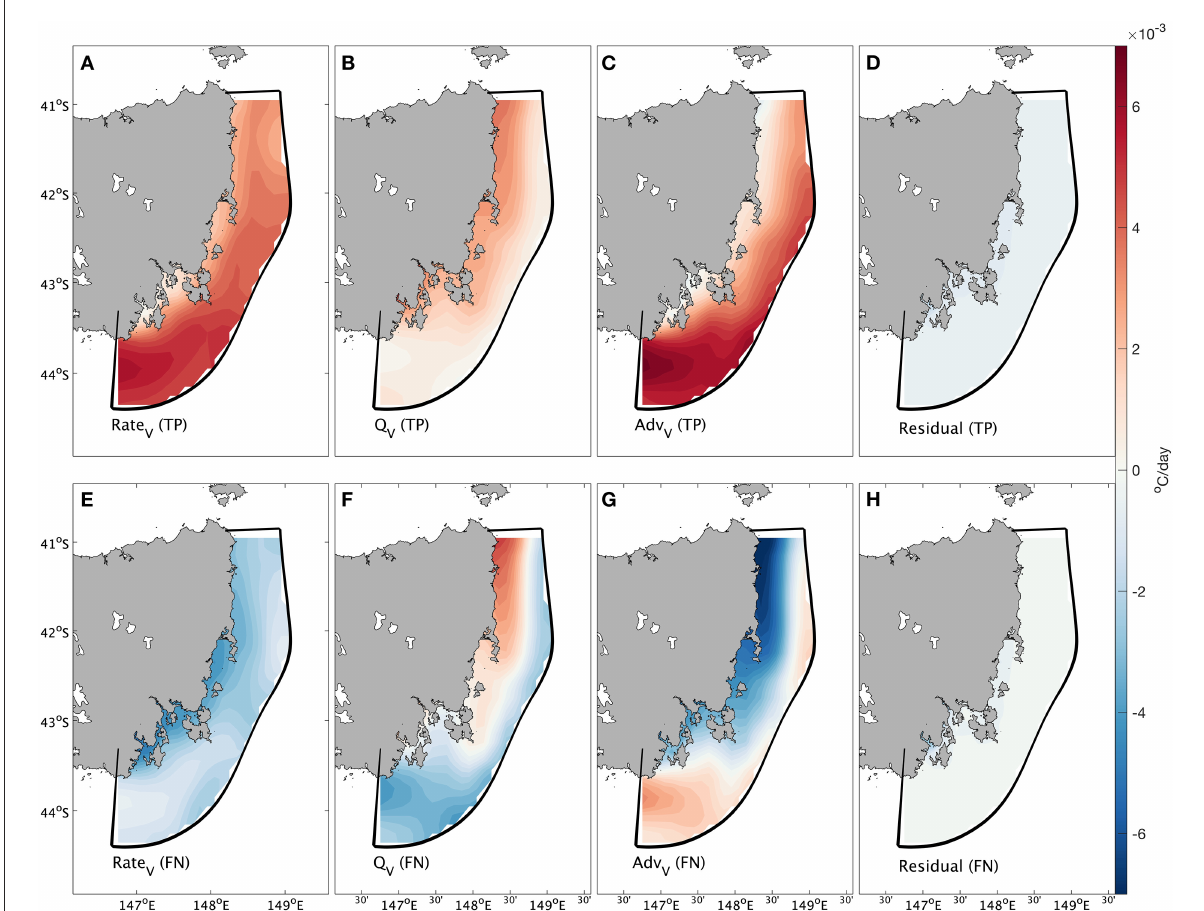
FIGURE14 Results from the heat budget analysis. (A) Total change rate anomaly ( ◦ C/day) averaged across all true positive forecasts. (B) Change rate anomaly ( ◦ C/day) due to surface heat flux averaged all true positive forecasts. (C) Change rate anomaly ( ◦ C/day) due to advection averaged across all true positive forecasts. (D) Change rate anomaly ( ◦ C/day) due to residuals across all true positive forecasts. (E) Total change rate anomaly ( ◦ C/day) averaged across all false negative forecasts. (F) Change rate ( ◦ C/day) due to surface heat flux averaged all false negative forecasts. (G) Change rate anomaly ( ◦ C/day) due to advection averaged across all false negative forecasts. (H) Change rate anomaly ( ◦ C/day) due to residuals across all false negative